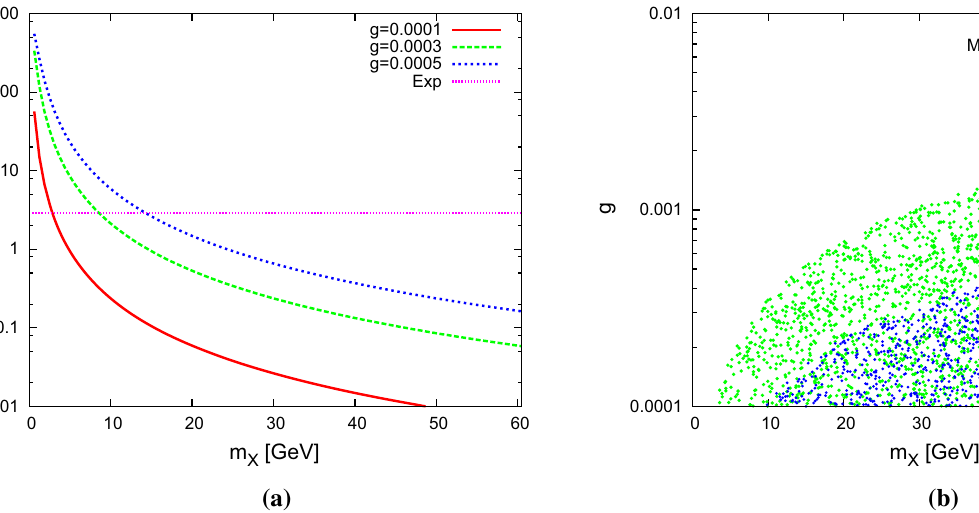
Fig. 12 a Br ( H 1 → Invisible ) as a function of fermionic DM mass for different values of g coupling and M s = 500 GeV. b Scatter points depict the ranges of parameter space in the mass of fermionic DM and